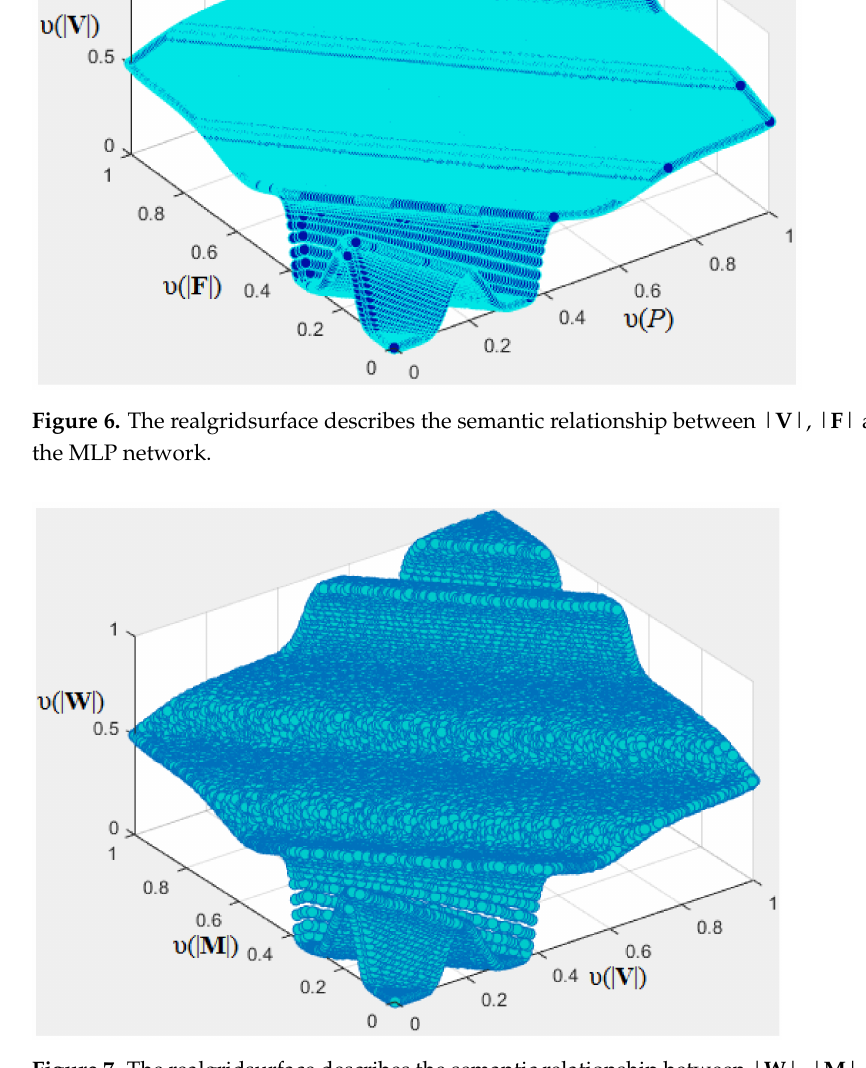
Figure 7. The realgridsurface describes the semantic relationship between | W |, | M | and | V | based on the MLP